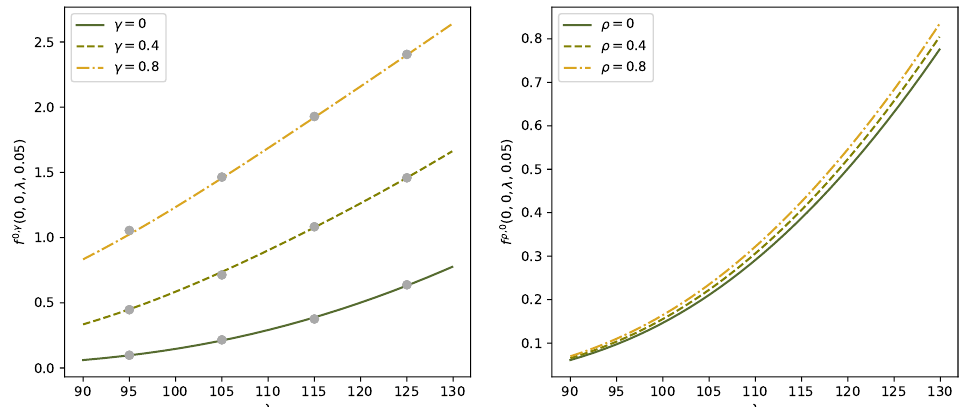
Figure 5. Solution f ρ , γ ( 0, l , λ , (cid:96) ) for l = 0, (cid:96) = 0.05 varying λ ∈ [ 90,130 ] , different levels of γ resp. ρ and ρ = 0 resp. γ = 0 ( left resp. right ) computed with the DNN-algorithm. The reference points are computed with Monte Carlo ( left , grey dots